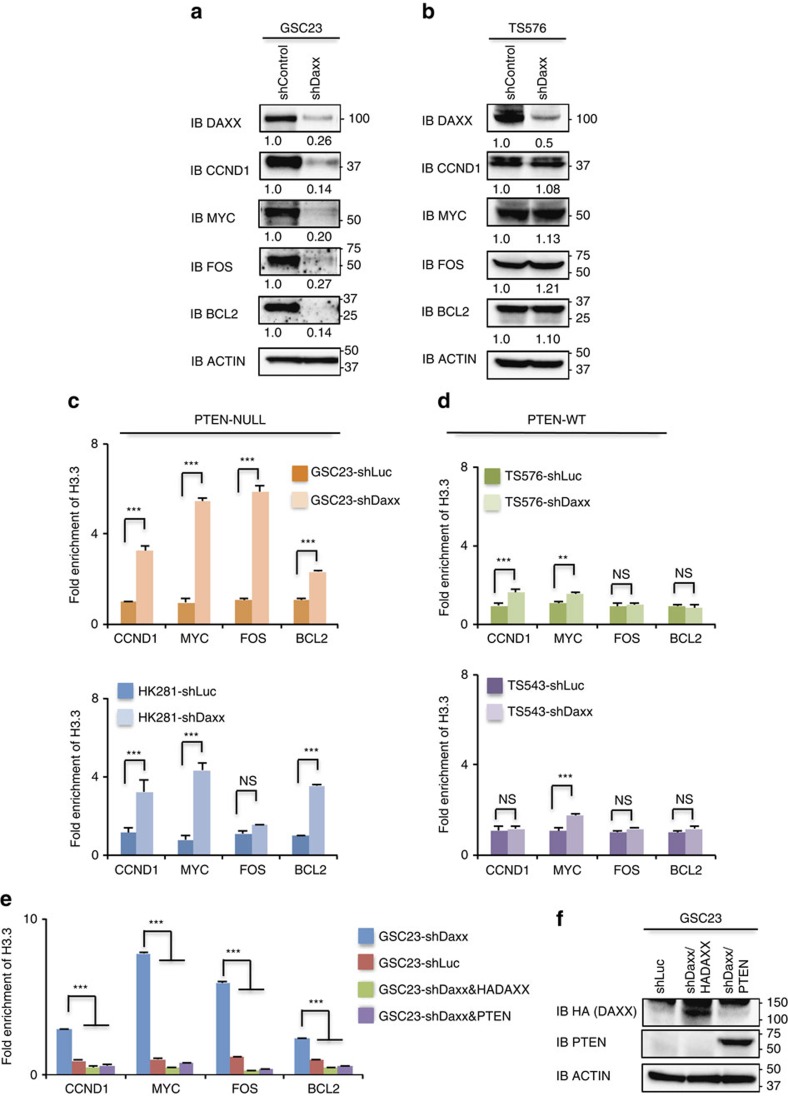
DAXX disruption compromises gene expression and restores H3.3 deposition in PTEN-deficient cells.(a,b) Total proteins were analysed by western blot in PTEN-deficient (a) or PTEN-expressing (b) GBM-spheres transduced with lentivirus shRNA control (shLuc) or shRNAs targeting DAXX (shDaxx). Actin is a loading control. (c,d) anti-H3.3 ChIP-qPCR was performed in PTEN-deficient (c) or PTEN-WT (d) GBM-spheres with stable knockdown of DAXX or with shControl. (e) ChIP-qPCR of H3.3 in Daxx-kd/PTEN-deficient GBM-spheres expressing a HA-DAXX-shRNA-resistant vector or PTEN-WT. For ChIP assays, bar graphs indicate fold enrichment of H3.3 over input (n=3 biological samples with three replicates each, **P<0.001, ***P<0.0001, one-way ANOVA). (f) Immunoblot analysis of HA-DAXX and PTEN expression in DAXX-kd or shControl GSC23 neurospheres. NS: no significant differences. Error bars represent s.e.m. from three different experiments. Numbers under the blots indicate fold ratios of protein levels relative to shControl after normalization to actin.